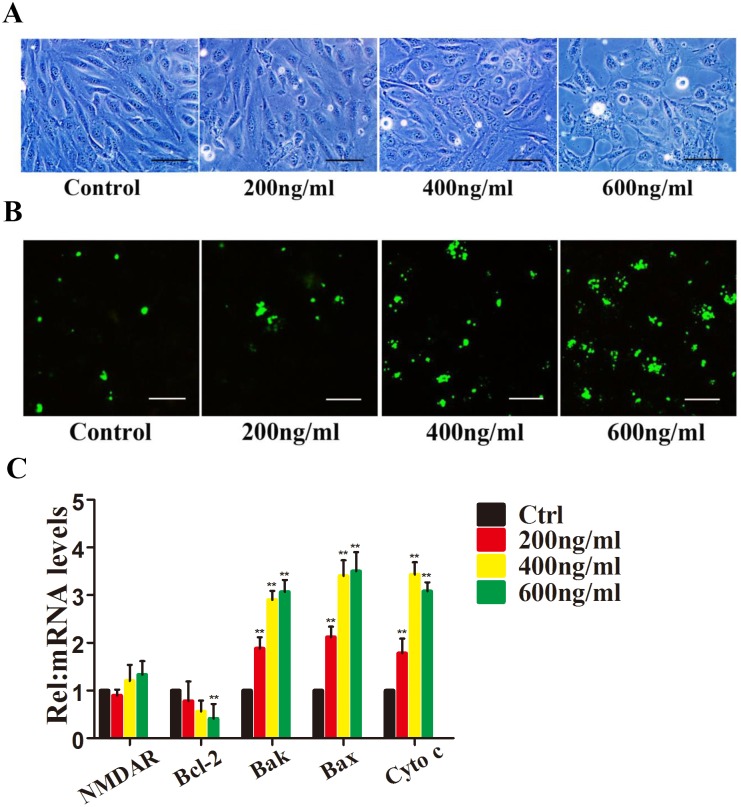
HIV-1 Tat induces apoptosis of HRMECs.HRMECs were incubated with 0, 200, 400, or 600/ml Tat for 48 hours. Representative phase-contrast microscopic images are shown, indicating the loss and swelling of HRMECs at different degrees (A). Immunofluorescence micrographs showing apoptosis using Annexin V-FITC staining (green). Scale bar: 50 µm (B). Quantitative analysis of Bcl-2, Bax, Bak and Cytochrome c expression using qPCR (*, P<0.05 vs. control) after HRMECs were treated with Tat at different concentrations for 48 h.